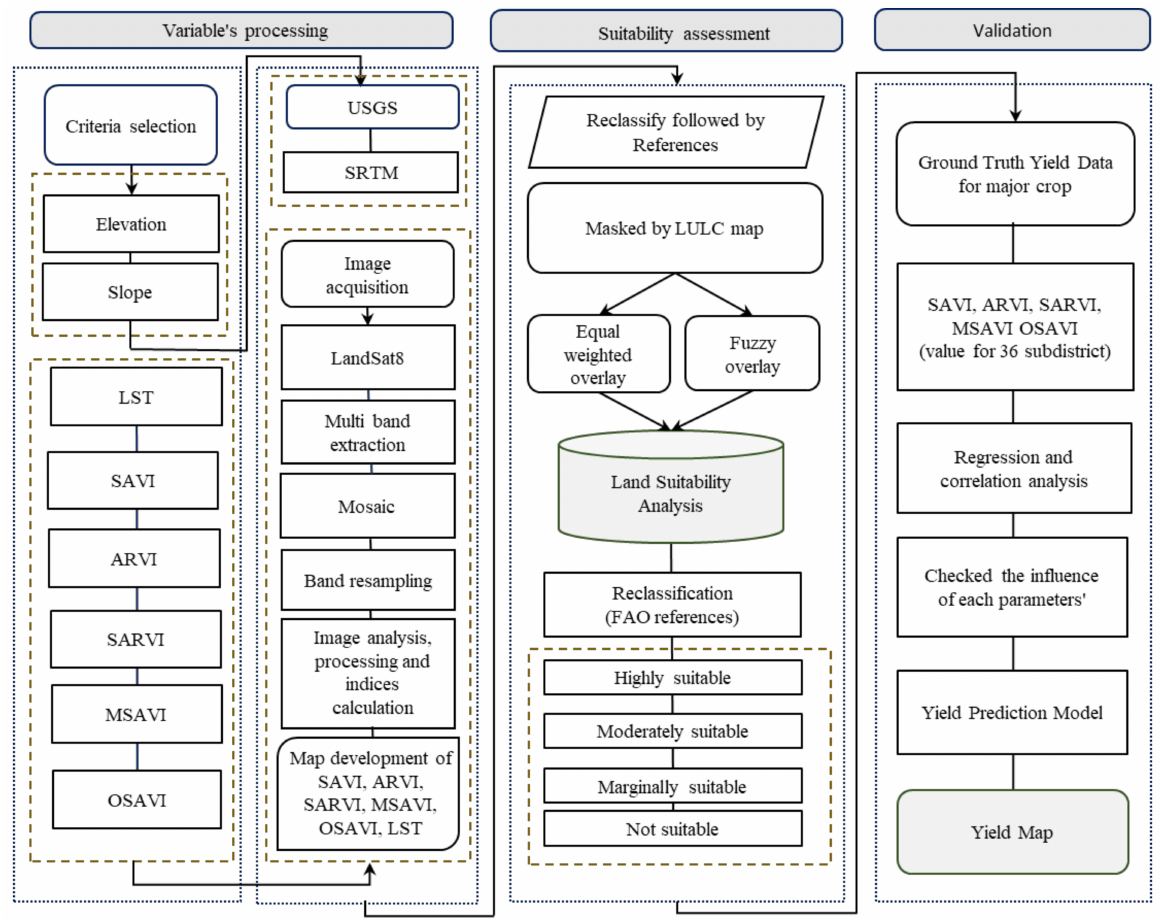
Figure 1. Framework for land suitability assessment using satellite remote sensing derived soil-vegetation